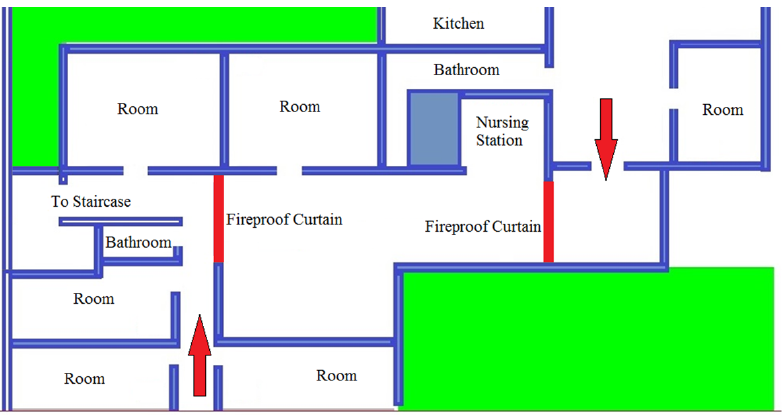
Figure 14. Schematic diagram of the temporary evacuation relay station built using a fireproof curtain with the 1.5-h fire-resistance